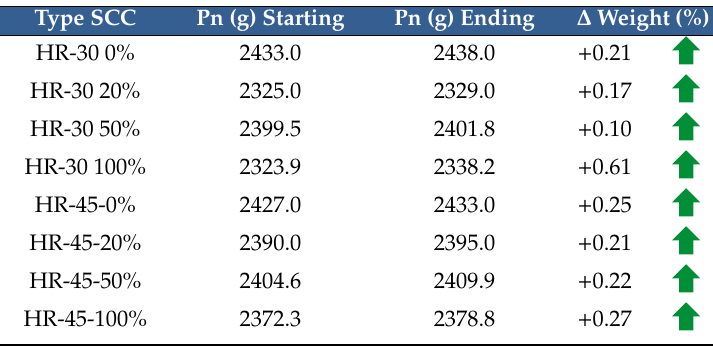
Table 7. Accelerated ageing by thermal shock: Pn mass variation.